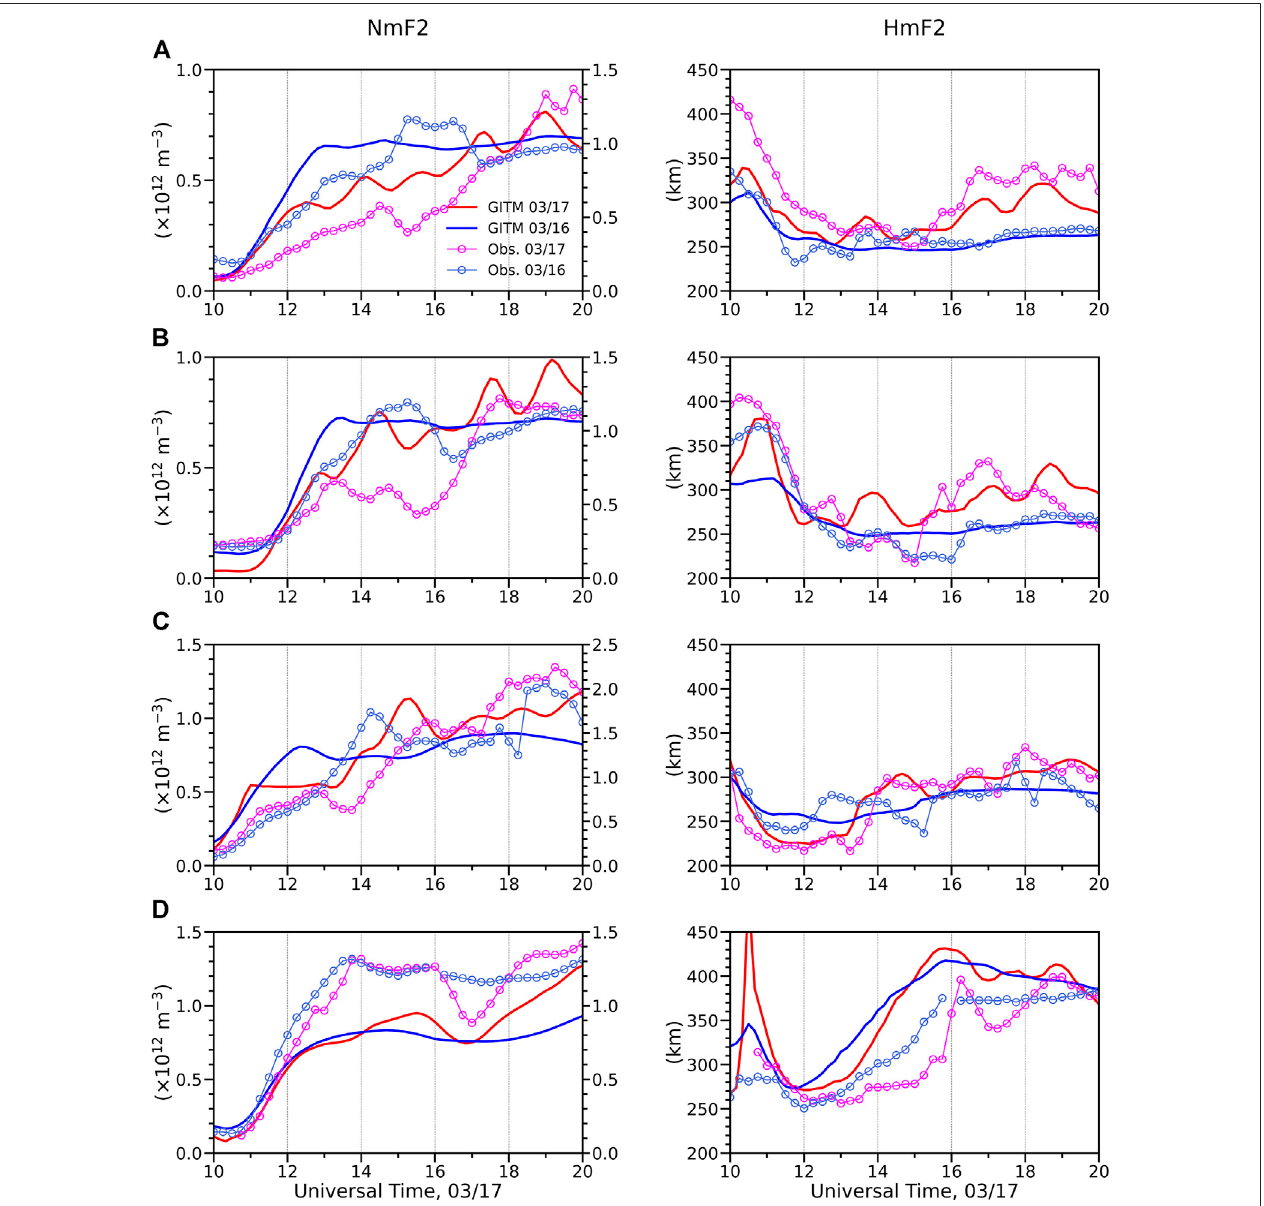
FIGURE 4 | Comparisons of the NmF2 and HmF2 between the measurements and AMIE-driven GITM simulation results at four stations at around 70 ° W. The sky blue and magenta lines with circles represent the parameters measuredon 03/16 and 03/17, respectively. The blue and red lines represent the simulation results on03/ 16 and 03/17, respectively. (A) Wallop Island (75.5 ° W, 37.9 ° N). (B) Eglin (86.5 ° W, 30.5 ° N). (C) Ramey (67.1 ° W, 18.5 ° N). (D) Jicamarca (76.8 ° W, 12.0 °